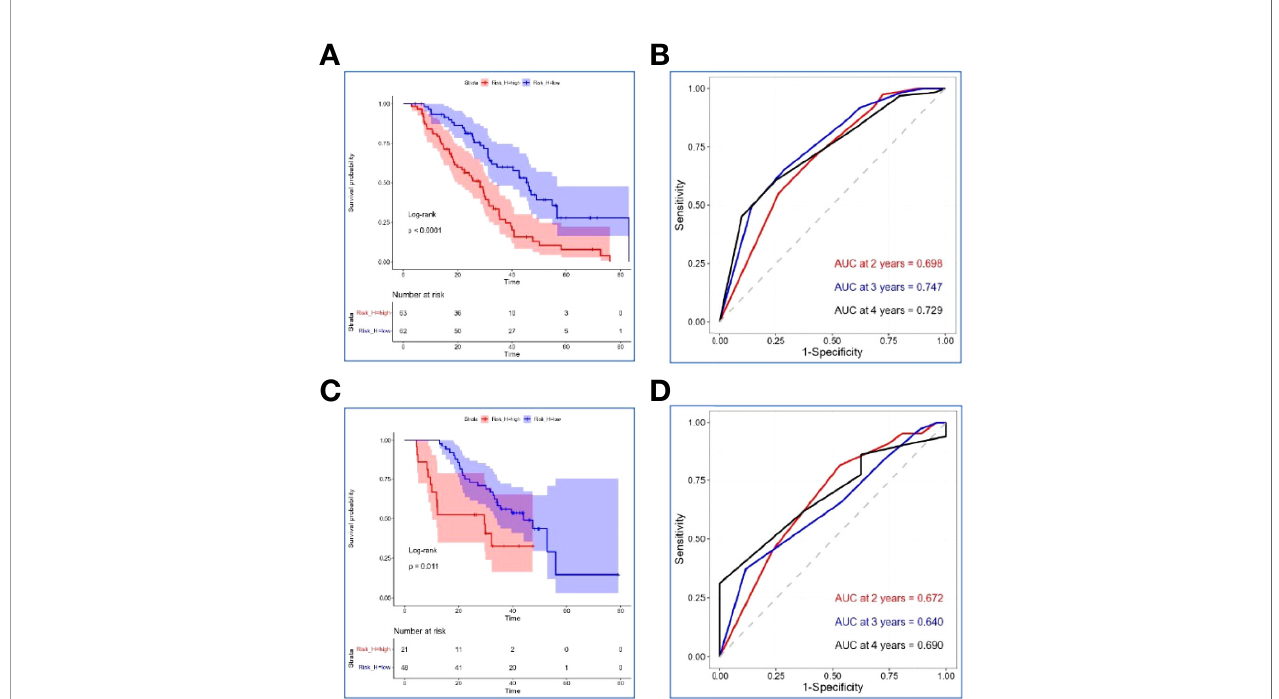
FIGURE 3 | Veri fi cation of the Risk-H in the internal set and external set. (A, C) Kaplan – Meier survival analyses of Risk-H in the internal set and the external set. (B, D) Risk-H performance in time-dependent receiver operating characteristic (ROC) analysis in the internal set and the external set.